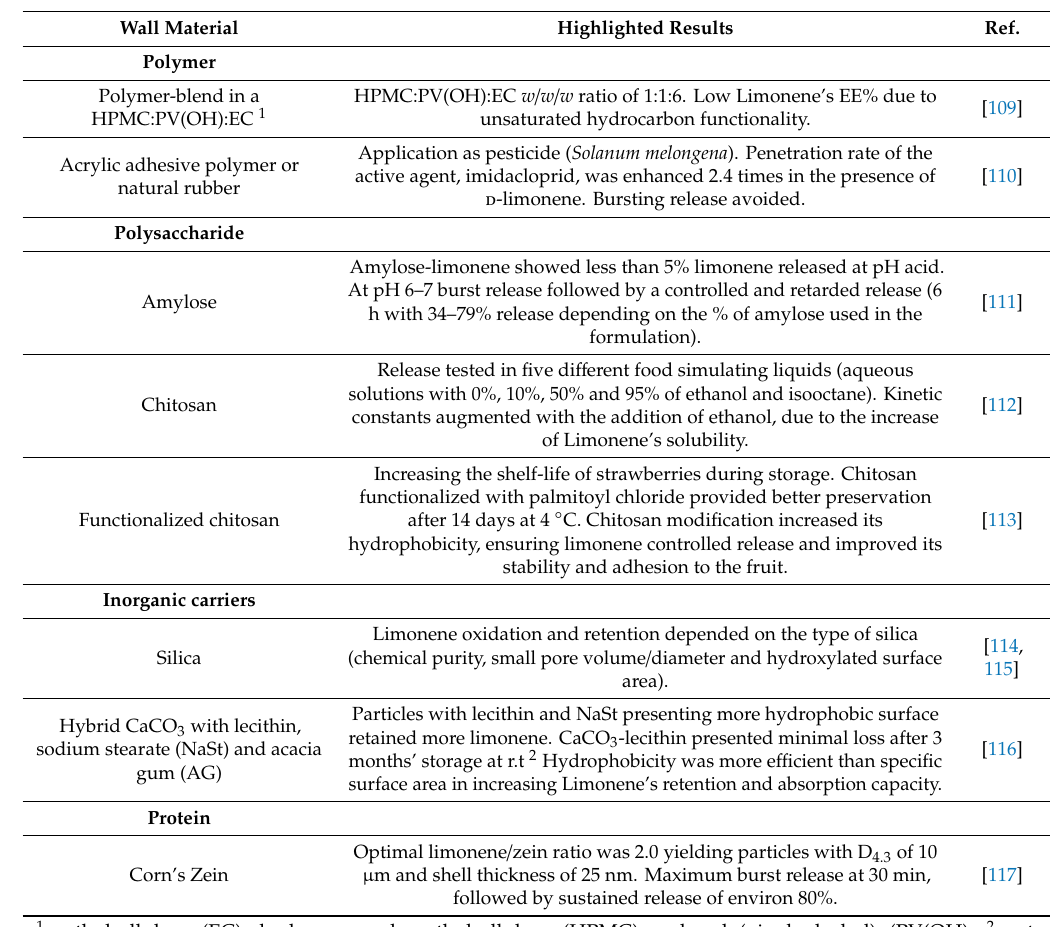
Table 1. Examples of wall materials used for Limonene’s encapsulation. Highlighted Results